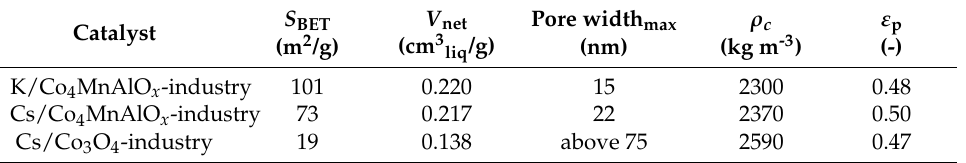
Table 3. Textural properties of commercially prepared